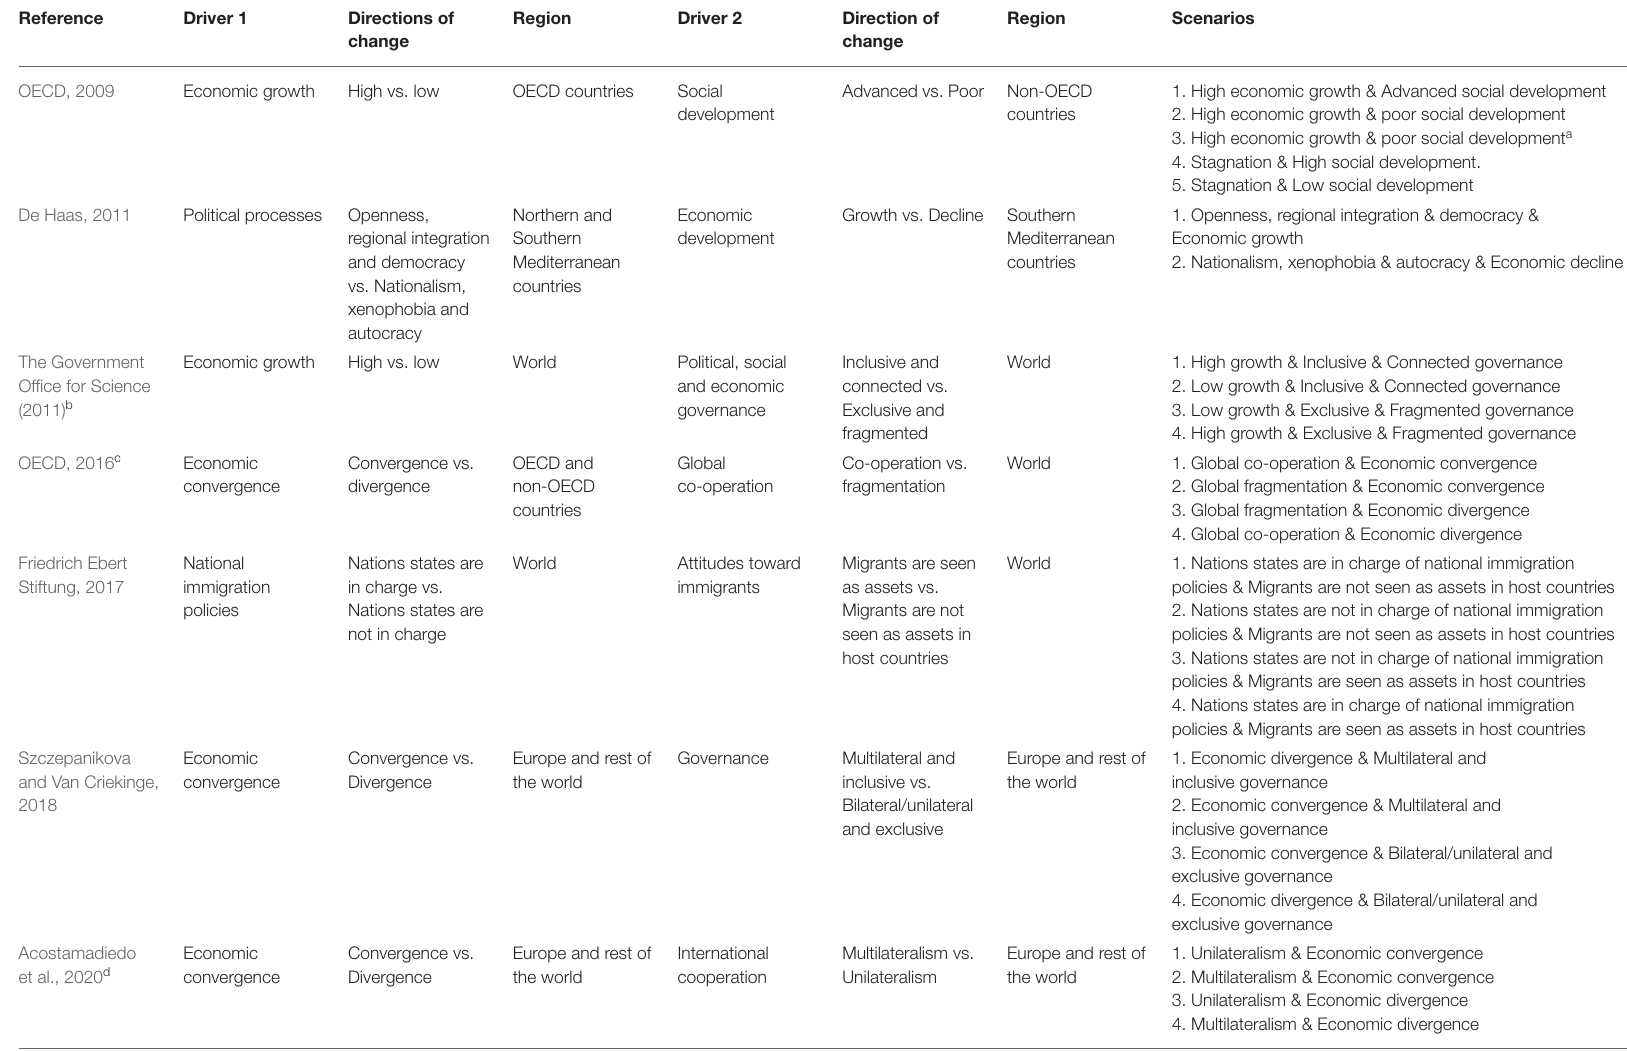
TABLE 1 | Overview of studies that applied scenario planning to migration, the drivers and directions of change they considered, and the resulting scenarios.